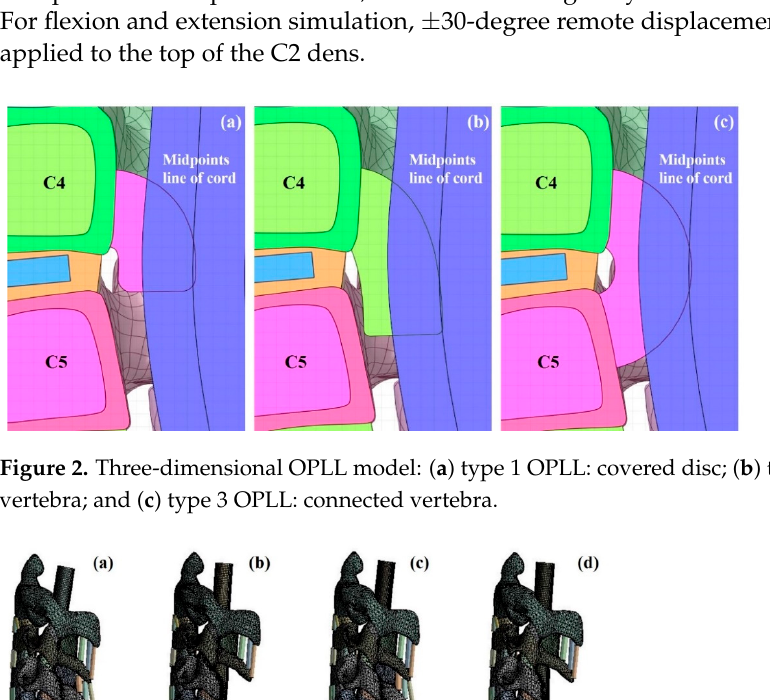
Figure 3. Finite element model of the OPLL cervical spine model: ( a ) non-surgery model; ( b ) C4 laminectomy model; ( c ) C5 laminectomy model; and ( d ) C4-C5 laminectomy model. OPLL, ossifi-